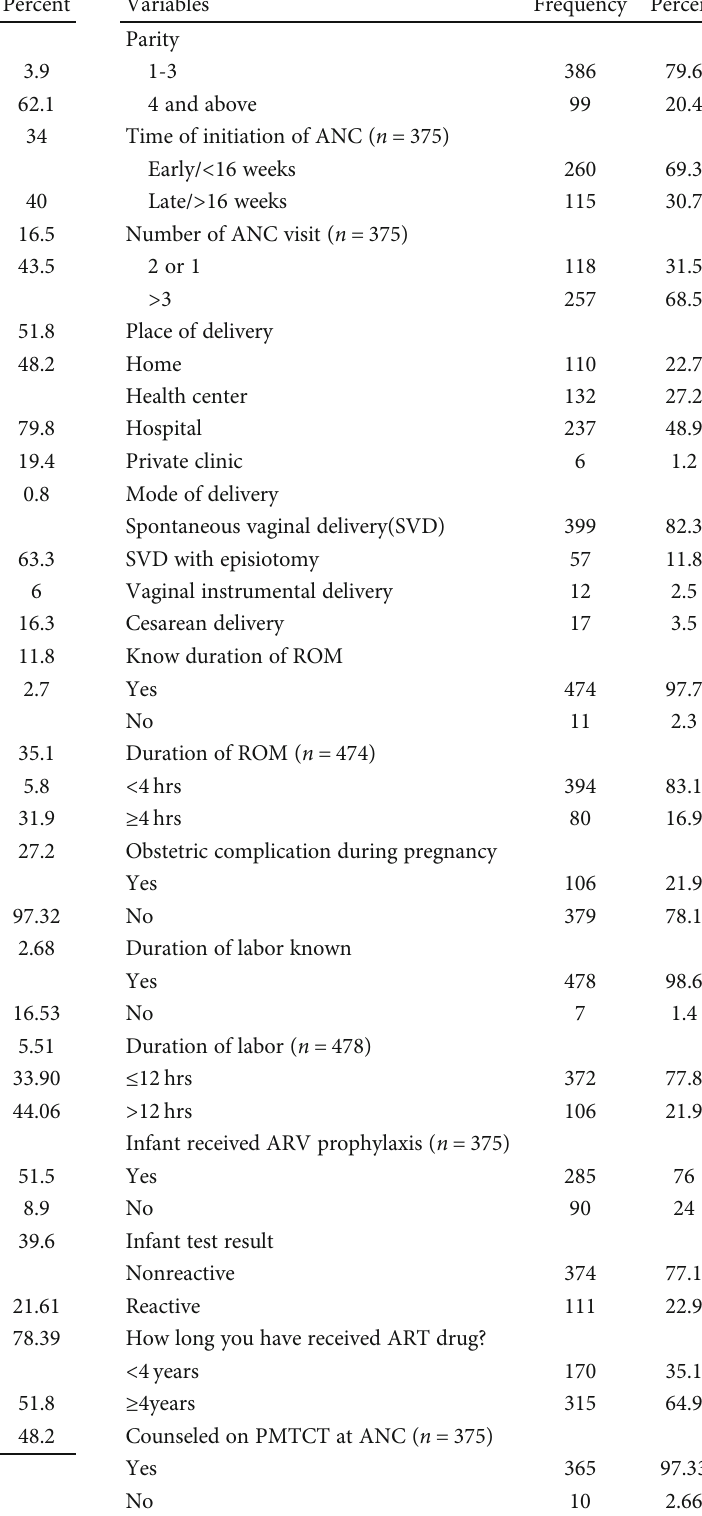
Table 1: Socio-demographic and economic characteristics of HIV- positive women in care in public health institutions in Gondar city, Northwest Ethiopia, 2017 ( n = 485 ).